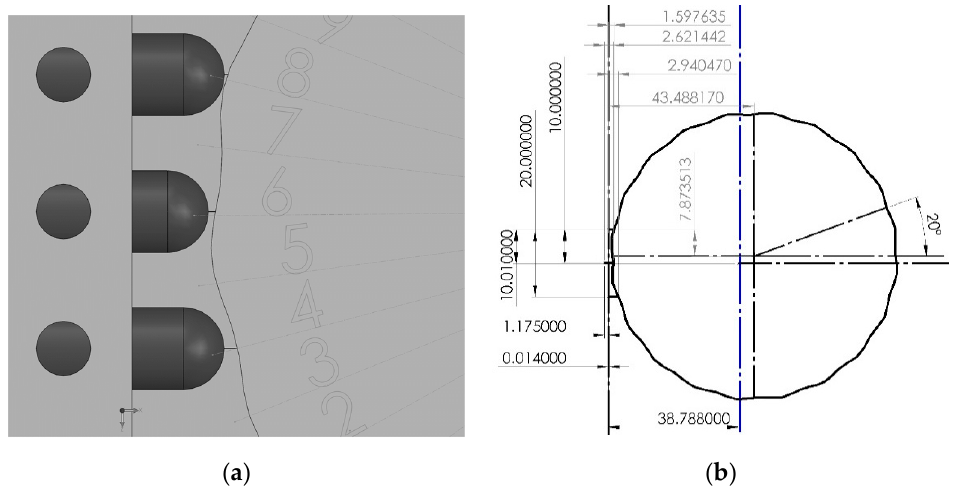
Figure 11. Roundness index based on the CAD model with R e = 42.500 mm, R p = 0.425 mm, ω ( t ) = 20 rad , a = 7.873513 mm, and b = 43.48817 mm. ( a ) 3D-CAD model. ( b ) 2D-CAD drawing. Table 8. Computation of roundness index using CAD data. The system parameters used were 𝑥 (cid:2870)(cid:3042) =